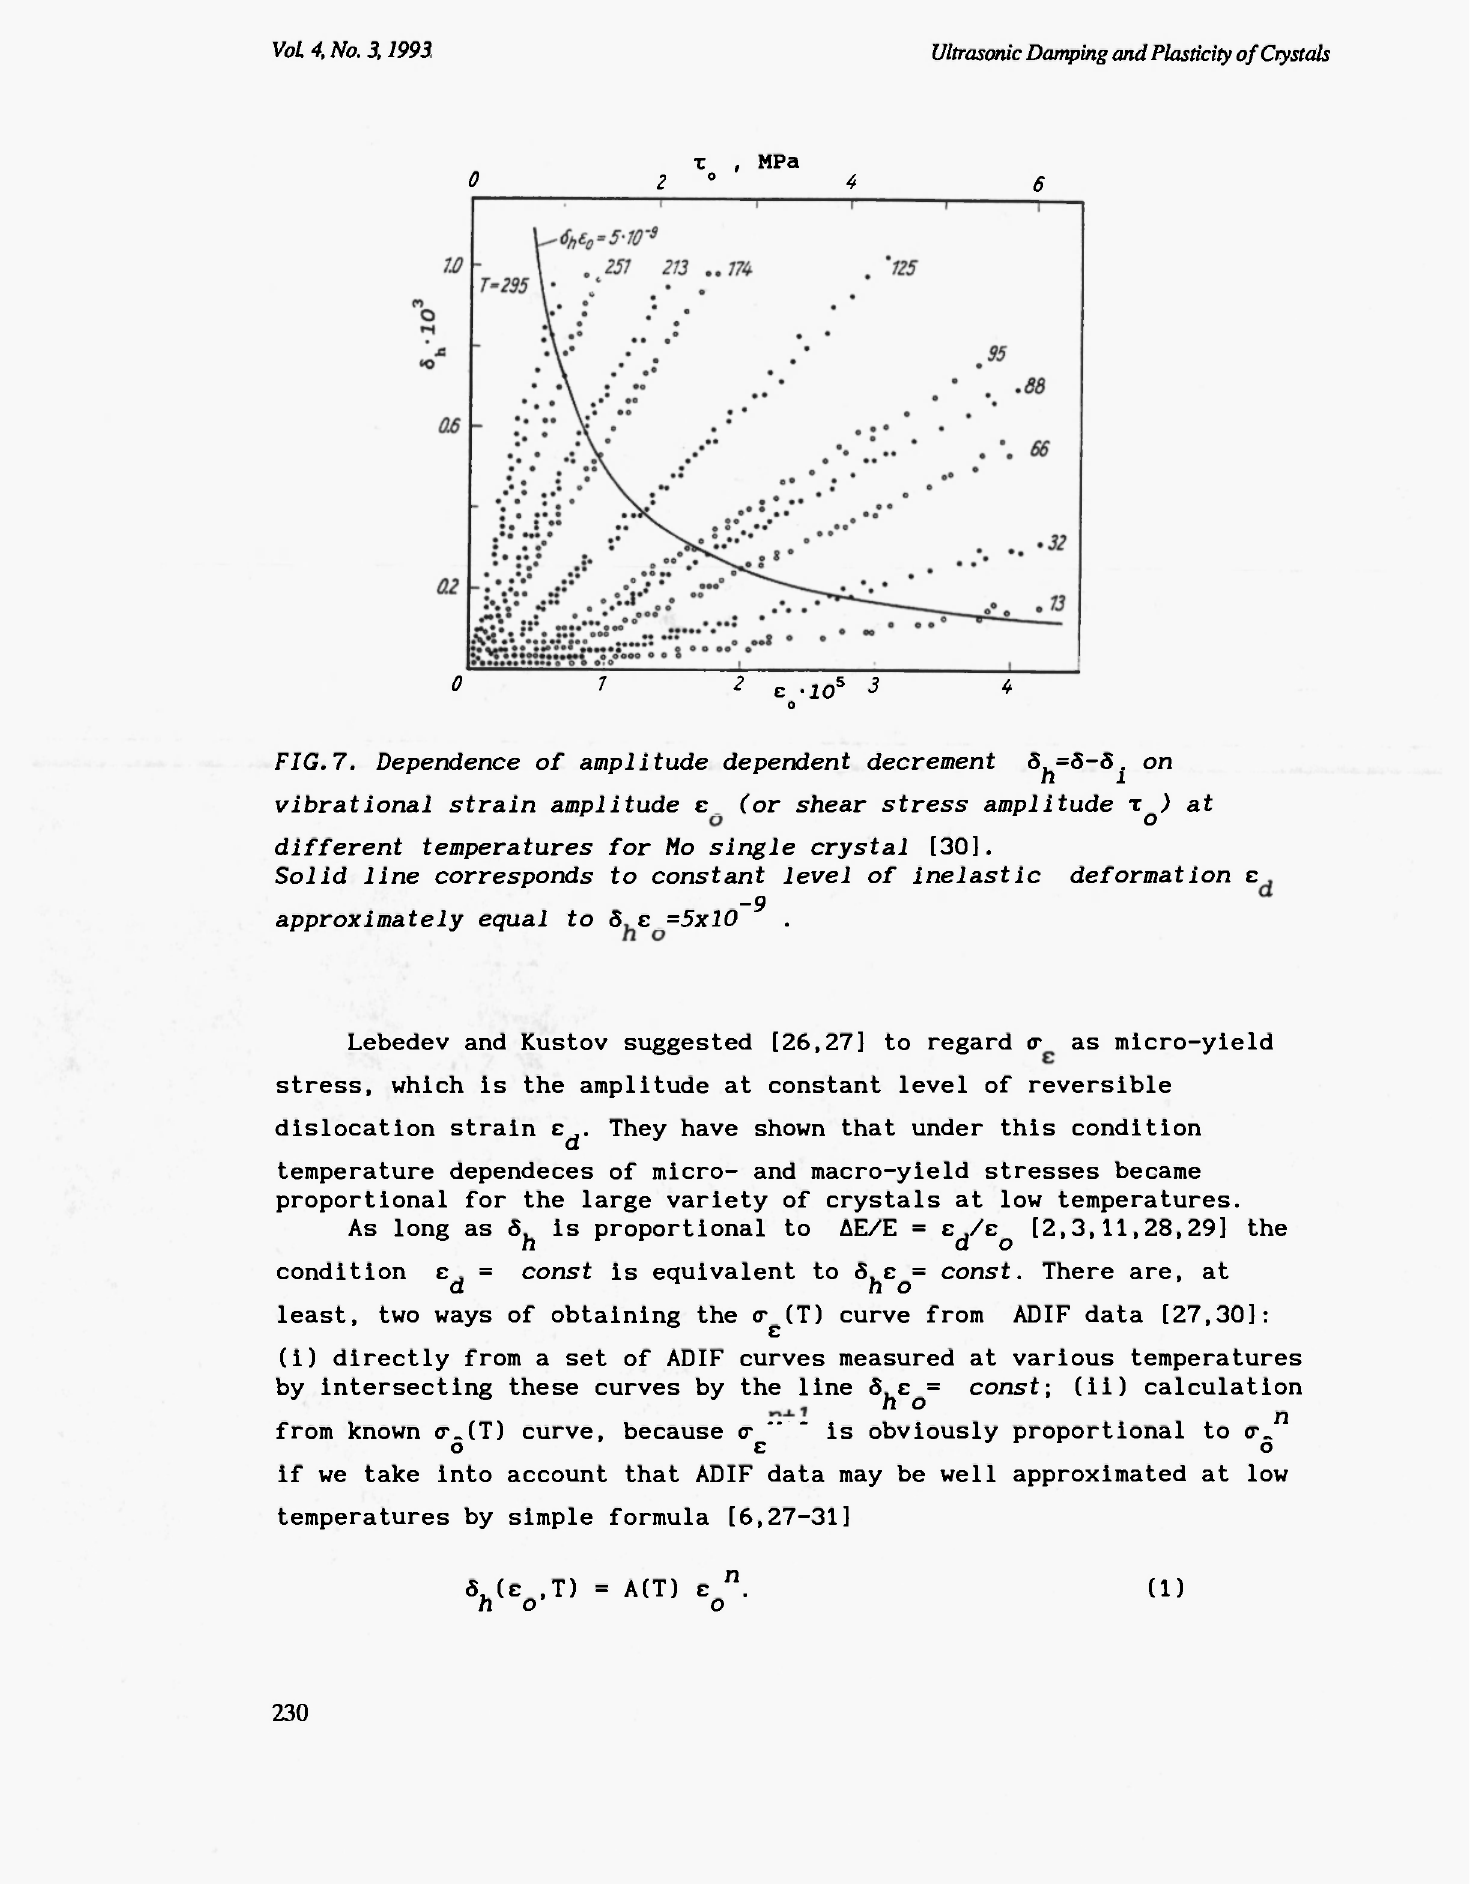
FIG.7. Dependence of amplitude dependent decrement δ^=δ-δ^ on vibrational strain amplitude (or shear stress amplitude t q ) at different temperatures for Mo single crystal [30]. Solid line corresponds to constant level of inelastic deformation ε approximately equal to δε =5x10 9